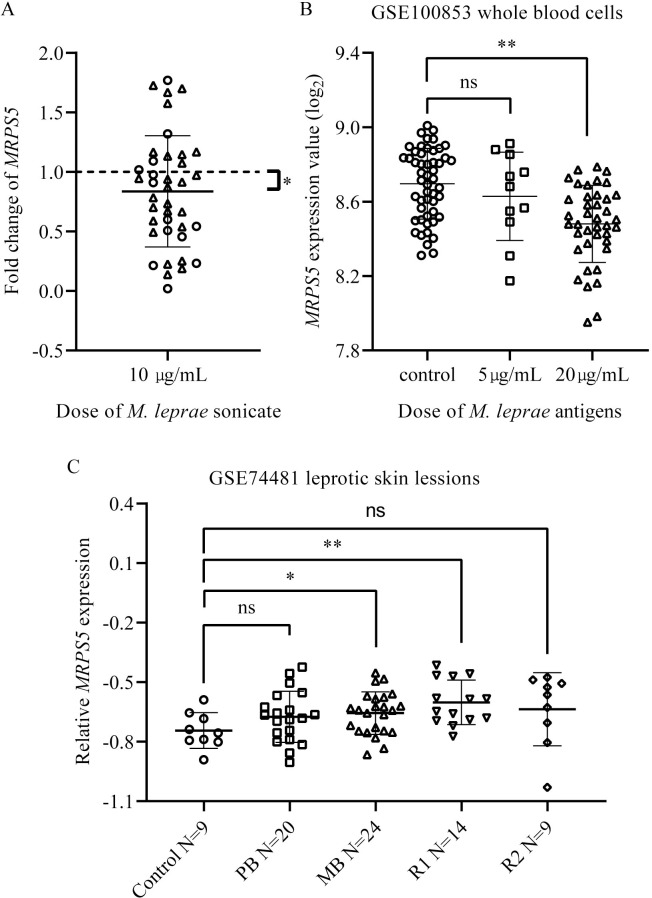
Variation of MRPS5 mRNA expression levels in PBMCs stimulated by M. leprae antigens and in leprotic skin biopsies.(A) Downregulation of mRNA expression levels of MRPS5 in peripheral blood mononuclear cells of individuals with or without leprosy stimulated by M. leprae sonicate. N = 39, *: P <0.05. Each hollow cycle represents an individual with leprosy (n = 13), each triangle represents an individual without leprosy (n = 26). The dotted line at 1 represents the fold change of unstimulated PBMCs. Y axis represents fold change vs unstimulated PBMCs. P value is calculated using the Paired Samples t Test. (B) Differentially expressed MRPS5 in whole-blood from individuals with borderline leprosy after stimulation with M. leprae sonicate. The expression dataset GEO: GSE100853 [39], which consists of 51 unrelated Vietnamese leprosy patients, was used to determine gene expression. Whole blood cells from each subject were divided into two equal parts, one was stimulated with M. leprae sonicate (5 μg/mL for 11 subjects and 20 μg/mL for 40 subjects), while the other remained untreated was used as control. **: P <0.01, ns: not significant. (C) MRPS5 mRNA expression in leprotic skin biopsies. The analysis was performed on the basis of the microarray expression data GEO: GSE74481 [40]. The dataset contains samples from leprotic lesions of 24 multibacillary (MB) leprosy patients, 20 paucibacillary (PB) leprosy patients, 14 patients with type I reaction (R1), and nine patients with type II reaction (R2), and meanwhile normal skin biopsies from nine healthy subjects were used as controls. *: P <0.05, **: P <0.01, ns: not significant.